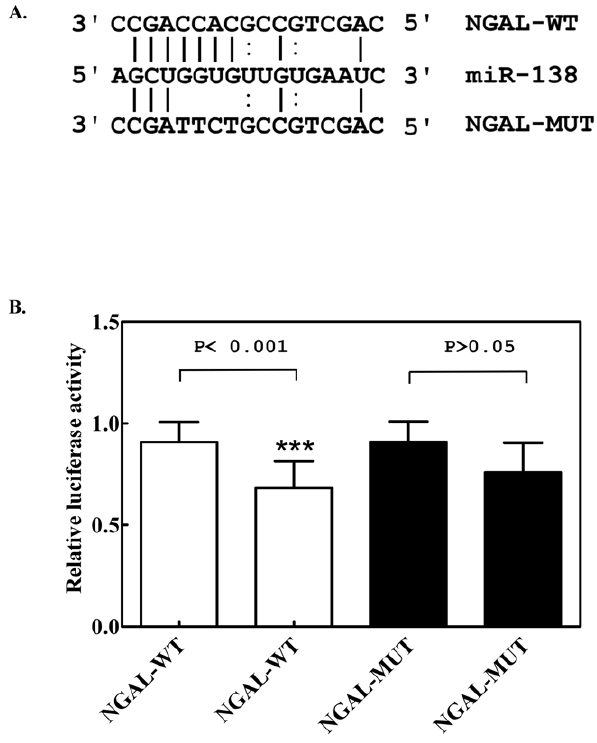
Figure 5. Identification of miR-138-specific target in the 3 9 UTR sequence of NGAL. (A) Base pairing between miR-138 and wild-type NGAL-3 9 UTR (NGAL-WT) or mutant NGAL-3 9 UTR (NGAL-MUT) at the miR-138 target site. (B) Luciferase assay of HEK-293T cells transfected with a luciferase reporter gene construct that included an NGAL-3 9 UTR wild-type (NGAL-WT, in white columns) or mutant (NGAL-MUT, in black columns) sequence, and then transfected with miR-138. The left column in white (or in black) indicates the control miR-transfected cells, and the right column in white (or in black) indicates the miR-138 transfected cells. Values represent mean 6 SE of five experiments. NC: negative control, transfection with a random oligomer instead of miR-138. *** indicates p ,